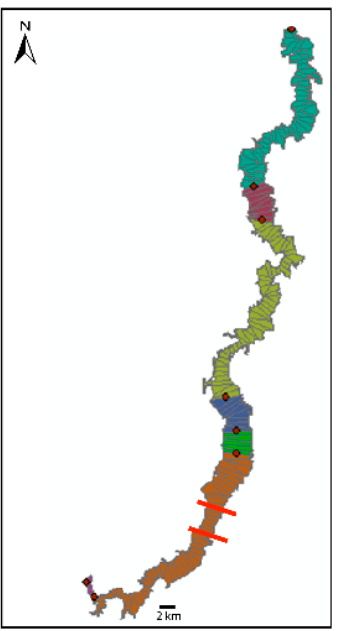
Figure 7. Example of segmentation of a continuous, quantitative attribute (the VB width of a stretch of the Magdalena River) via Hubert’s statistical test (as implemented in the FCT): the output (stretches of different colors) is questionable as, for instance, the segment delimited by the two red lines (amongst many others) would certainly be classified by expert judgment as narrower than the one above it (notice that there is no criterion linked to the length, as Hubert’s test determined both short and long segments).